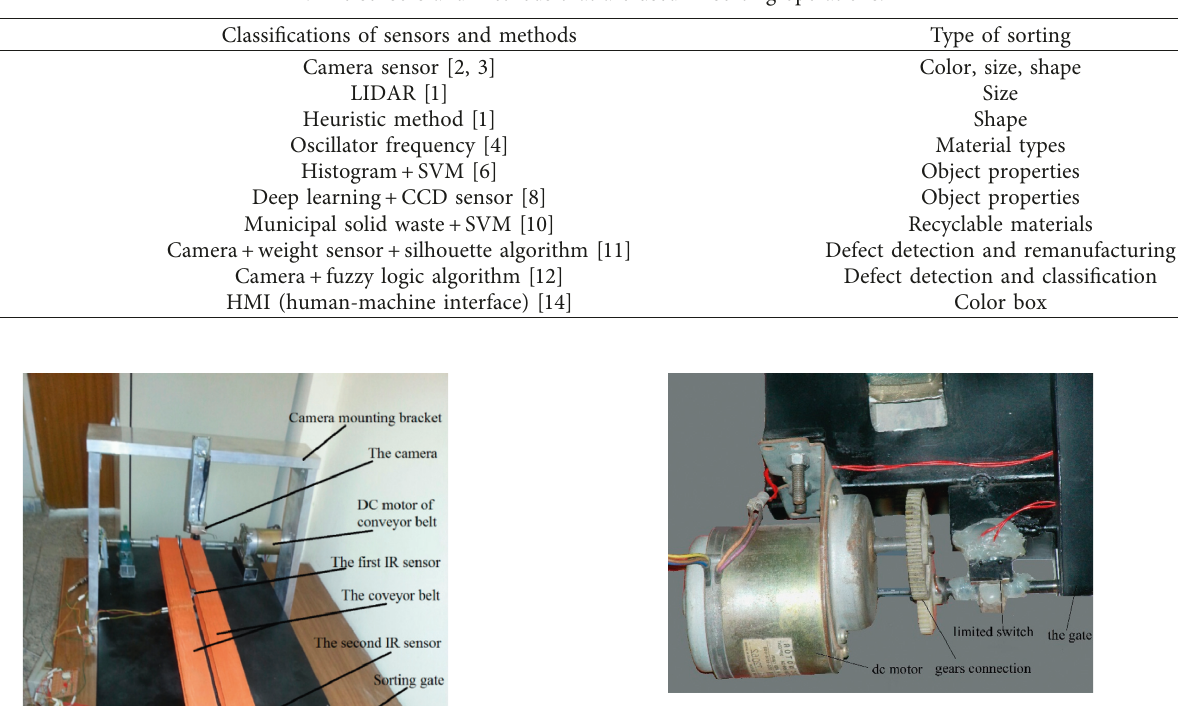
Figure 3: The sorting gate